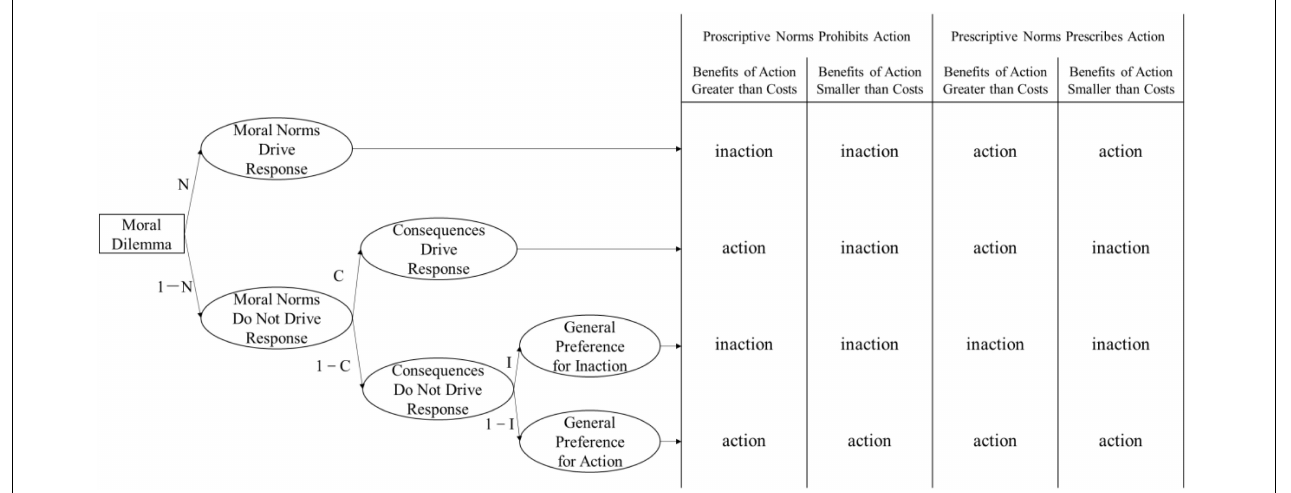
FIGURE 1 | NCI model. The positions of the C parameter and N parameter are exchanged based on the original CNI